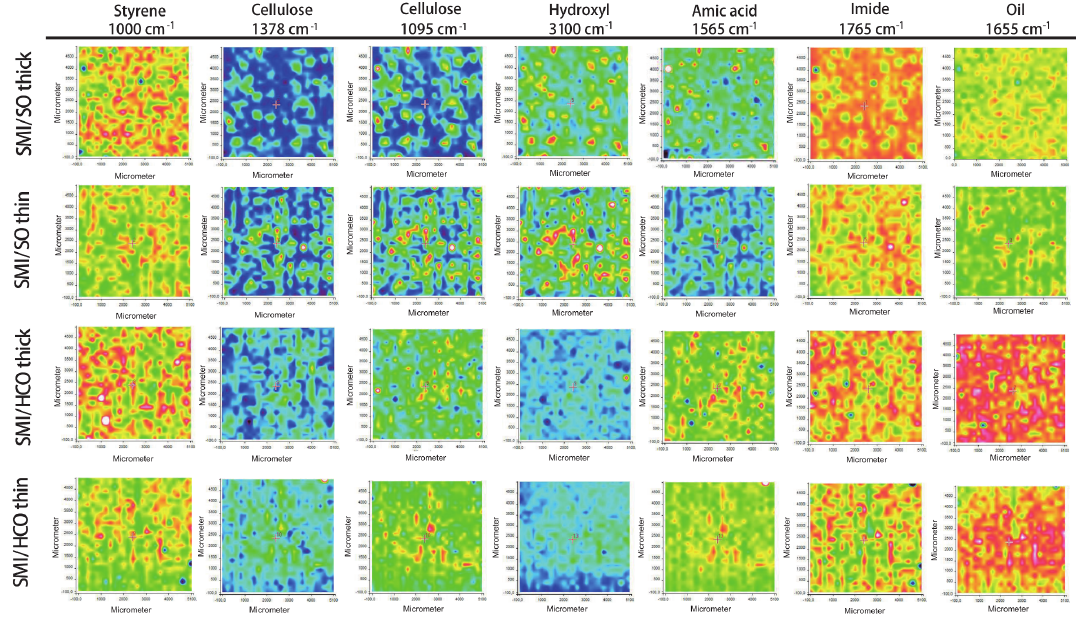
Figure 9. Raman maps (5 × 5 mm 2 ) with single wavenumbers representing different coating and substrate components at the surface for SMI/oil paper